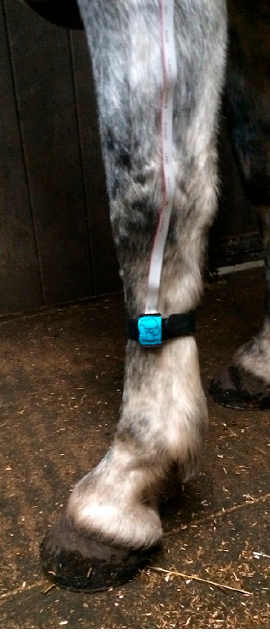
Figure 6. Thermal probe positioned on the limb with a carefully tensioned elastic and Velcro ® band.